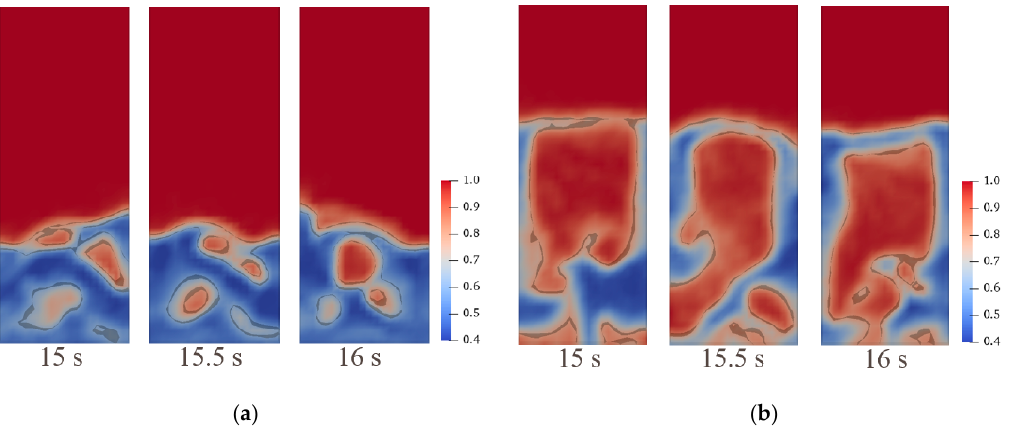
Figure 9. Instantaneous distribution of bubbles in the BFB under different superficial gas velocities: ( a ) 1.5 m/s; ( b ) 3.0 m/s. ( a ) 1.5 m / s; ( b ) 3.0 m /